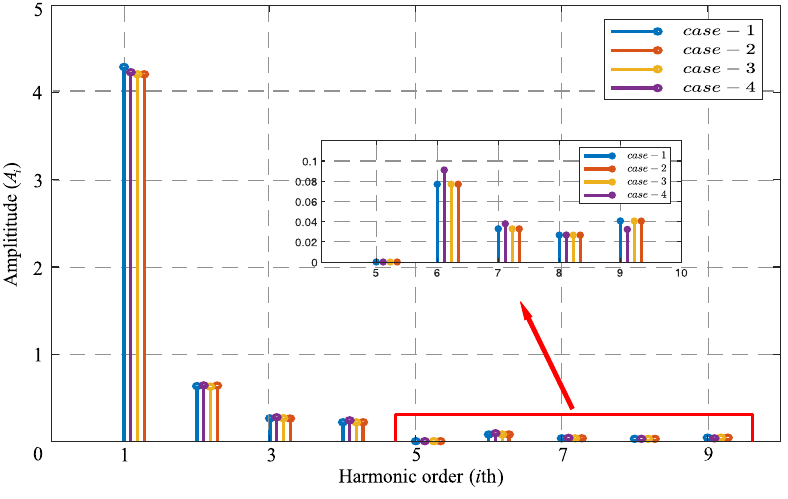
Figure 4. The harmonic components of the